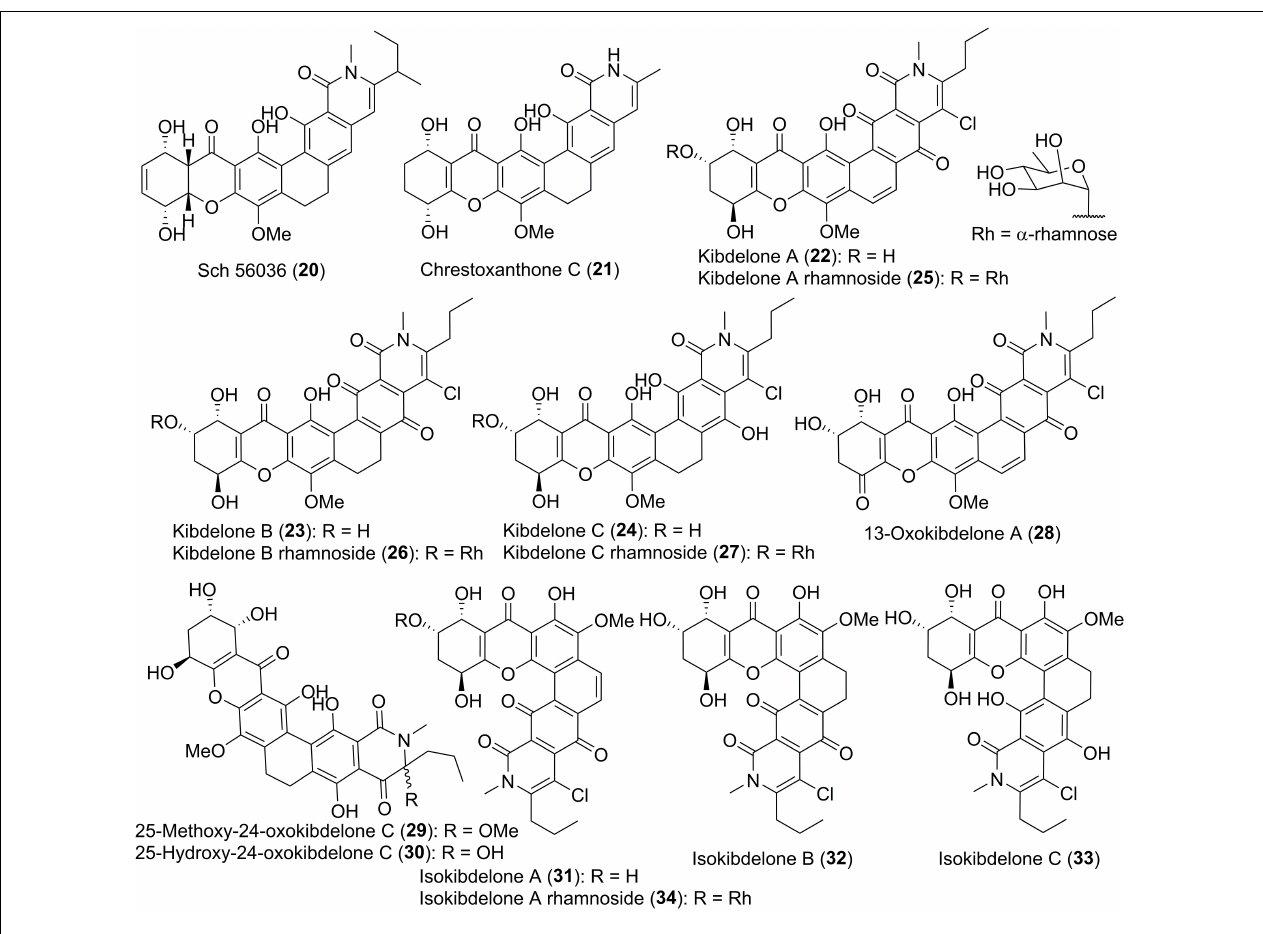
FIGURE 3 | Chemical structures of compounds 20–34